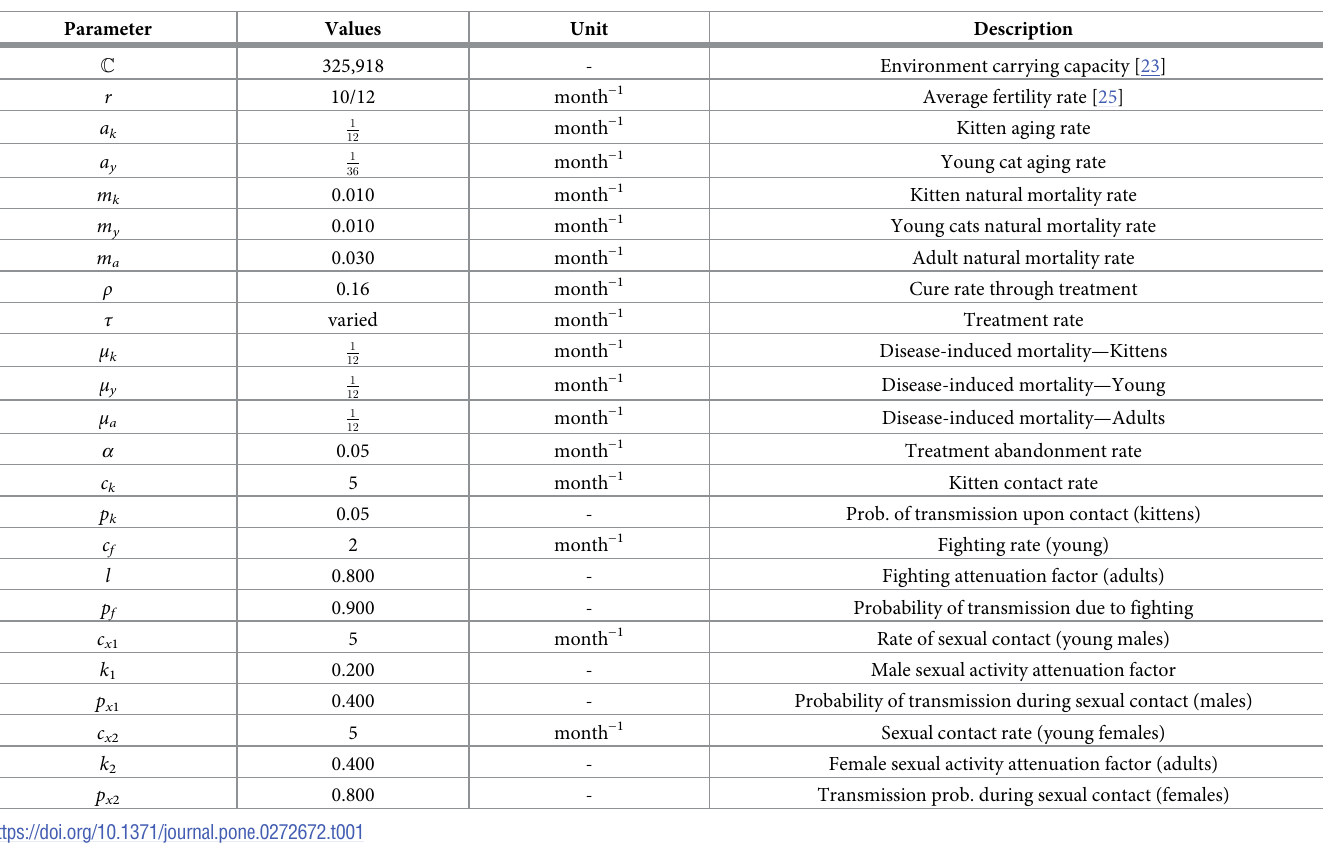
Table 1. Parameters of the model. Values and definitions.